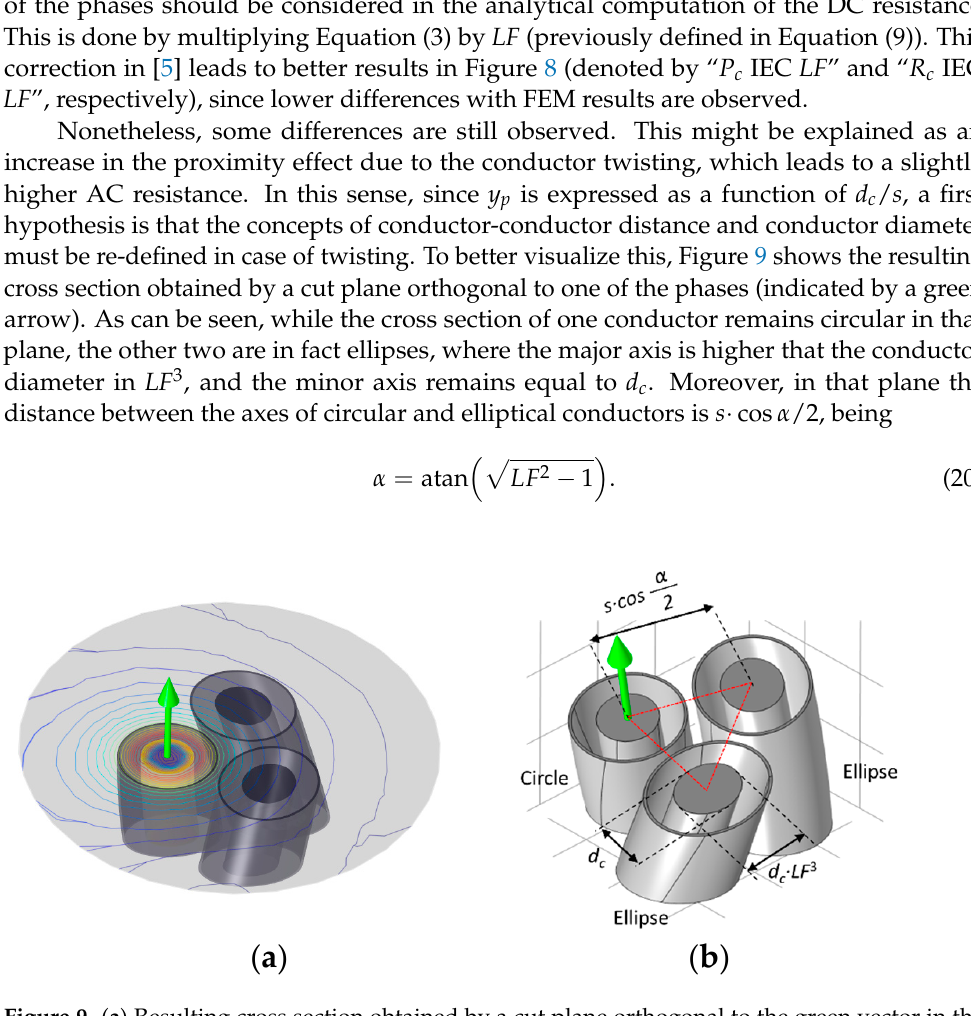
Figure 9. ( a ) Resulting cross section obtained by a cut plane orthogonal to the green vector in the direction of one of the phases and ( b ) distances and dimensions inside the cut plane.